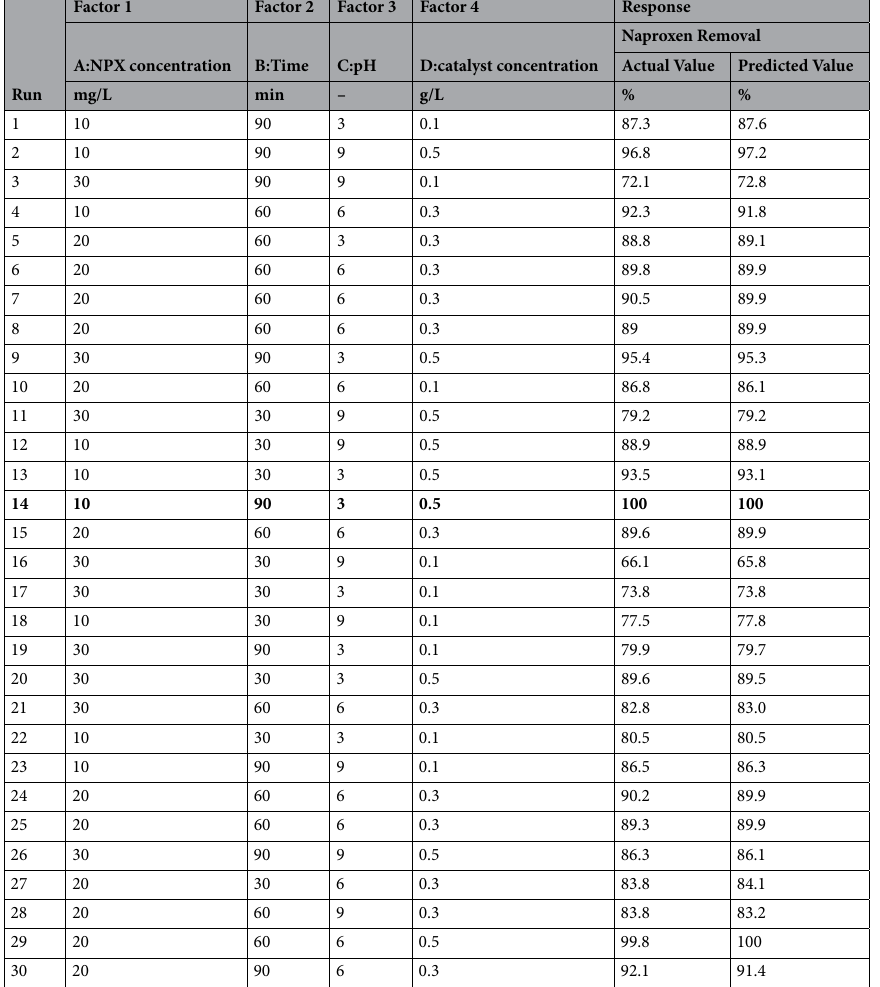
Table 3. Operational parameters range in the designed experiments and actual and predicted results in terms of naproxen removal. Significant values are in bold.